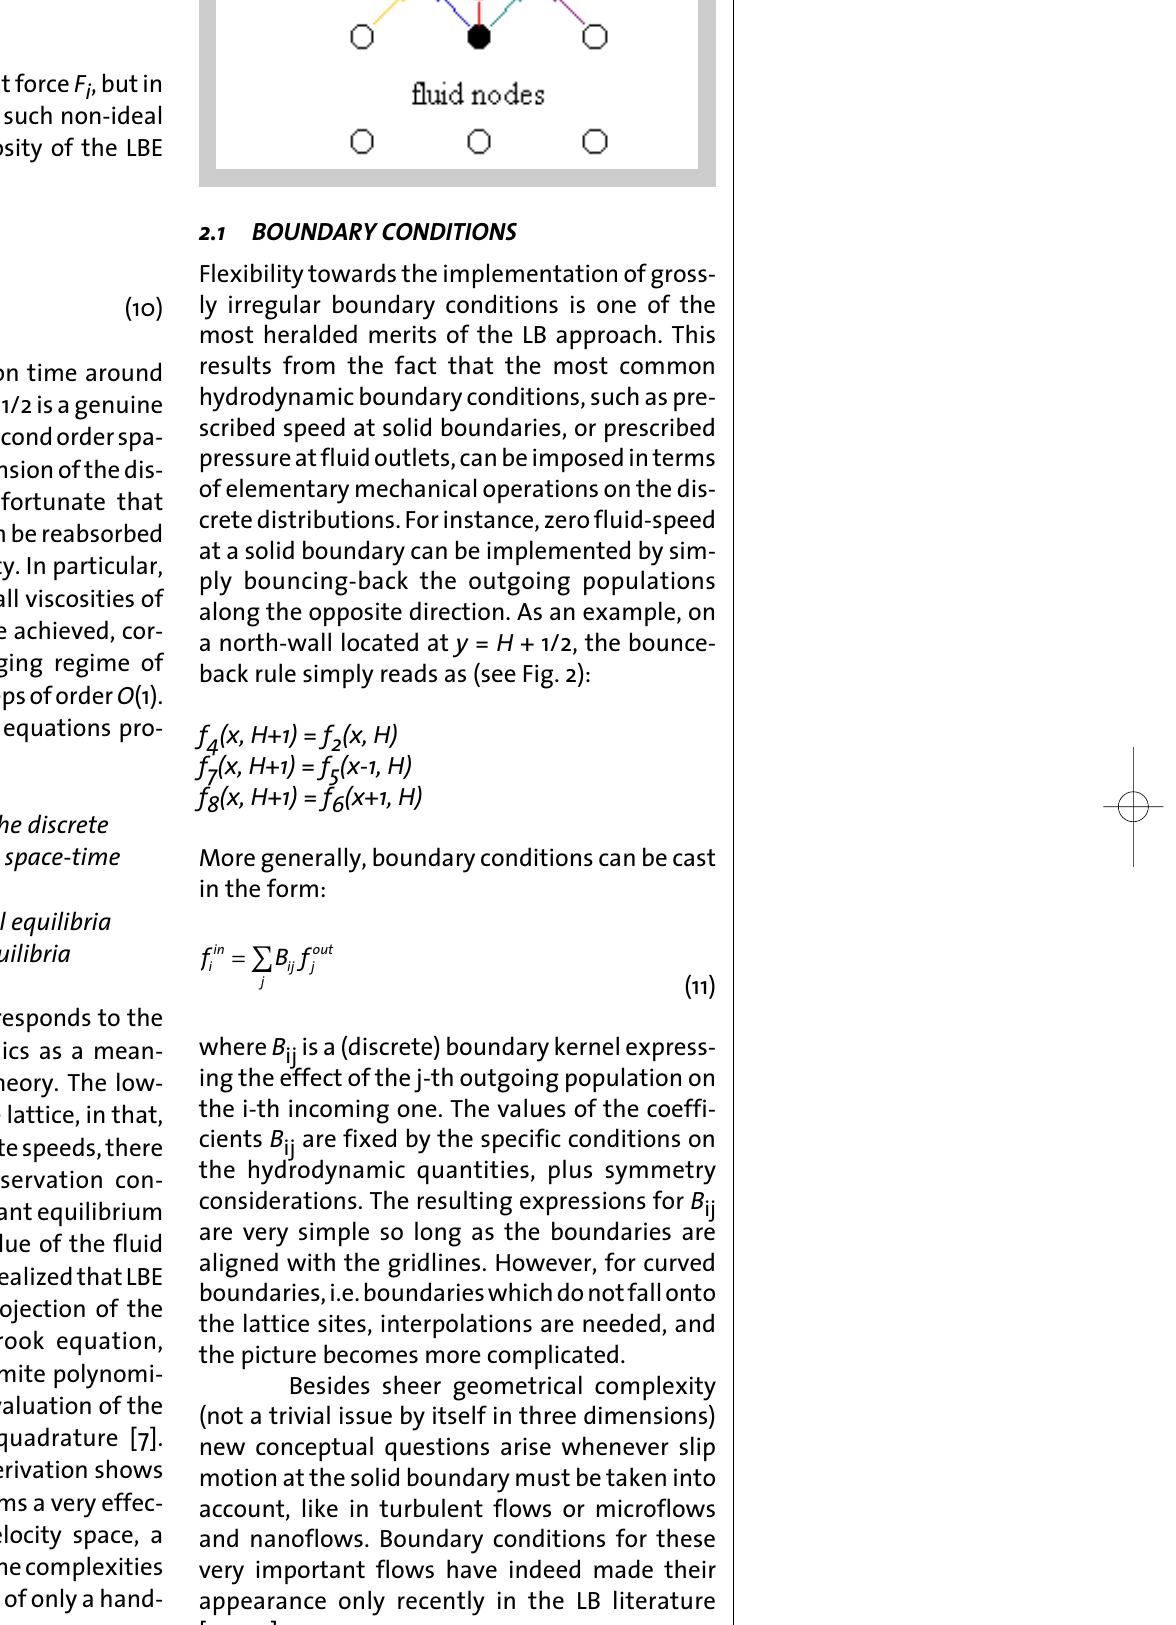
Figure 2: The bounce-back rule for no-slip boundary